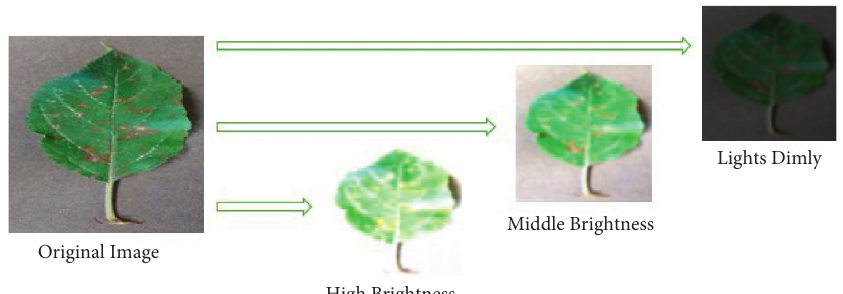
Figure 4: Contrast transform.